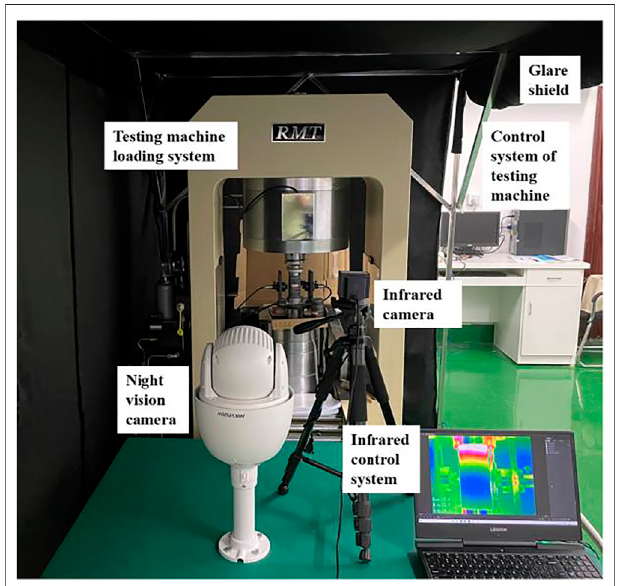
FIGURE 3 | Loading system diagram.